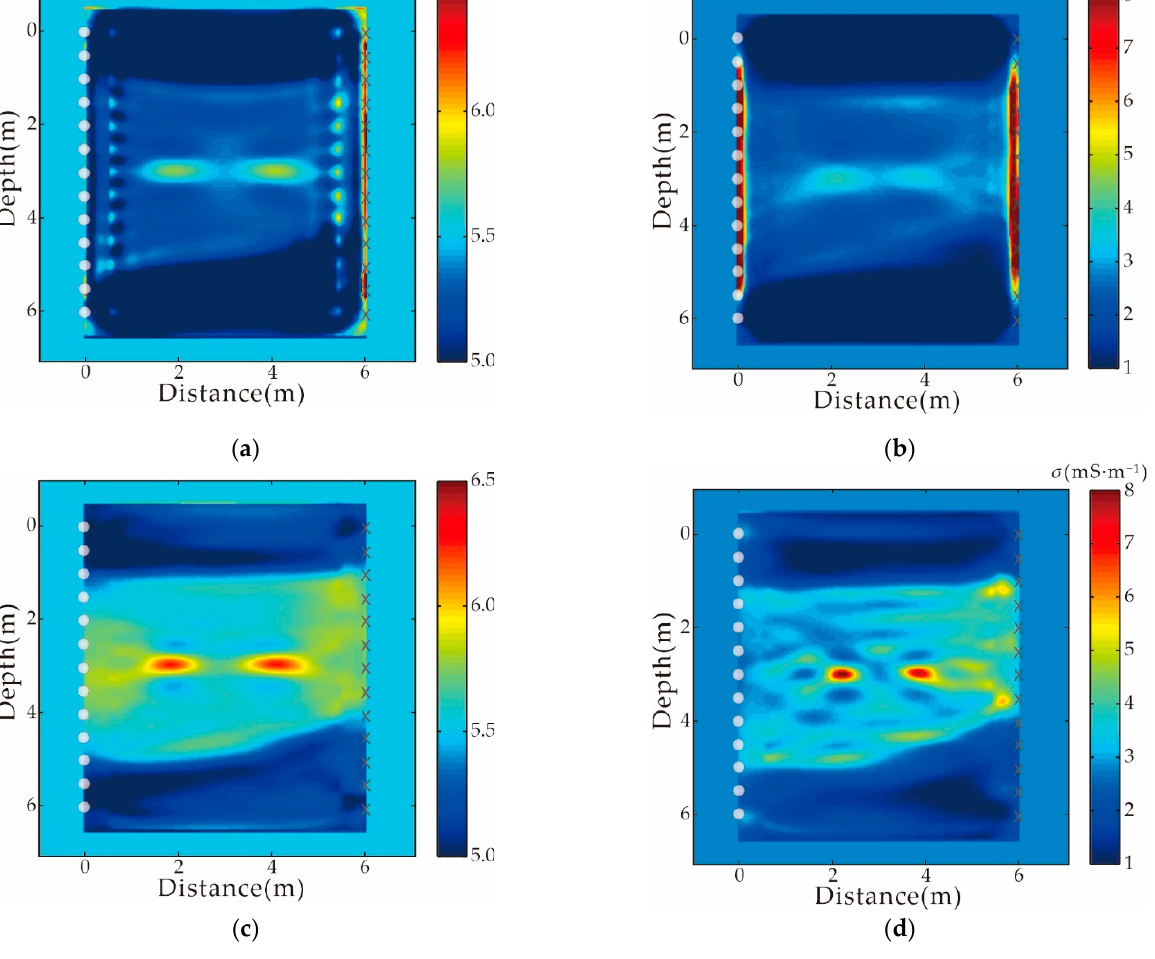
Figure 7. Inversion results using the wrong source wavelet. The traditional FWI obtains the ( a ) relative permittivity and ( b ) conductivity; SIEWI obtains the ( c ) relative permittivity and ( d )